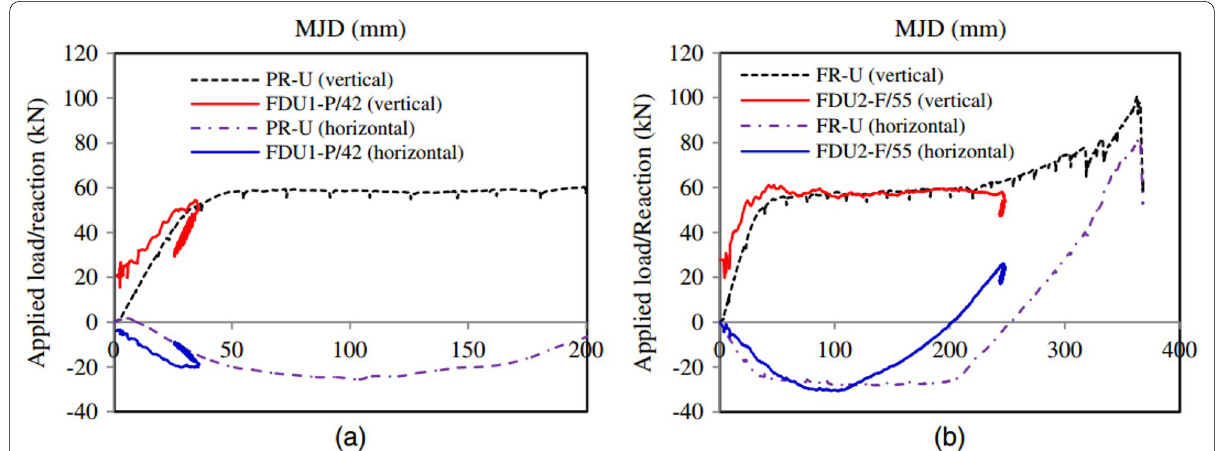
Fig. 8 Vertical displacement–reaction relationship under dynamic and static conditions (Left: Partial restrained Right: Fully restrained) Image by courtesy of Pham (Nanyang Technological